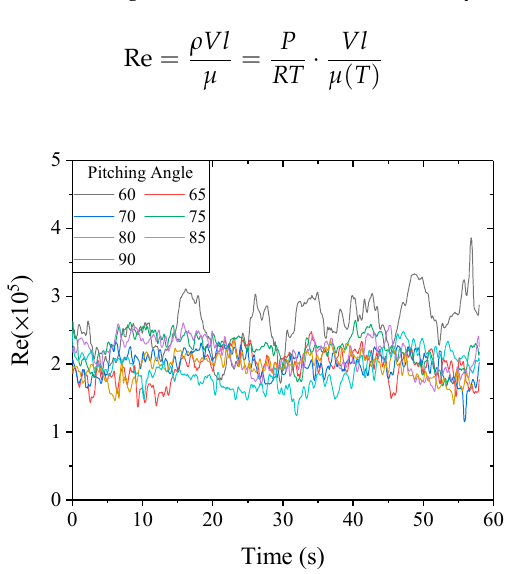
Figure 17. Reynolds number range at different pitching angle cases.